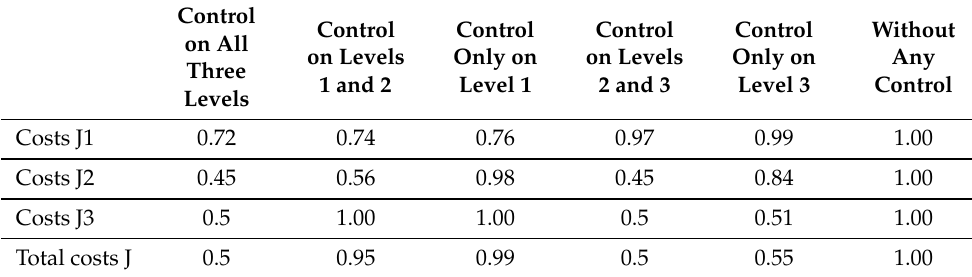
Table 2. Costs on each level relative to the costs in uncontrolled case.